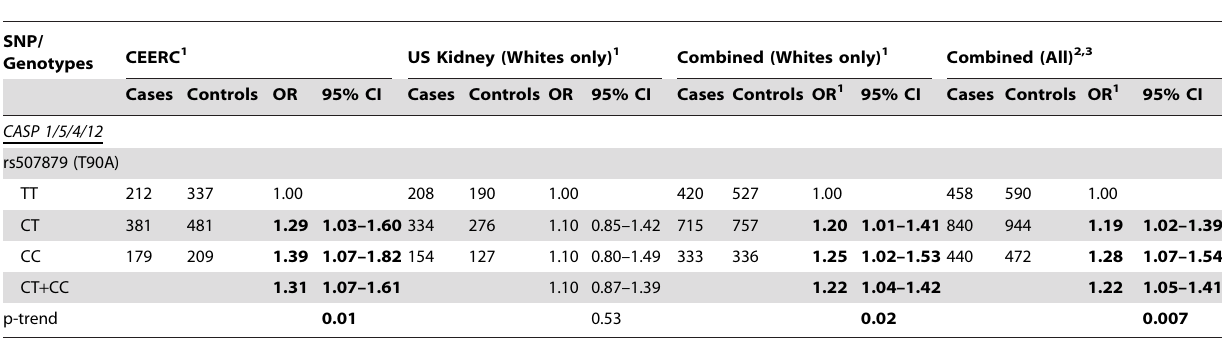
Table 5. Results from Replication of SNP rs507879 and Renal Cancer Risk.